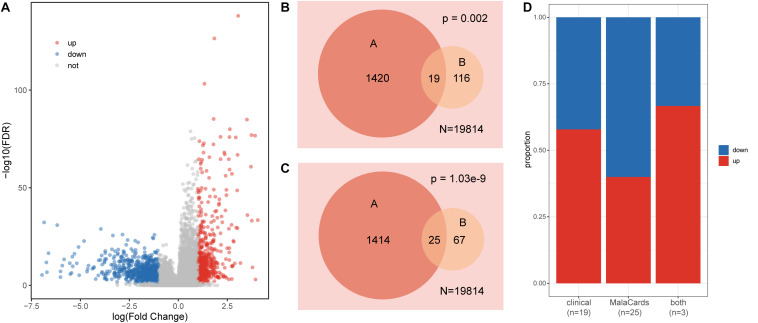
Characteristics of gene expression in colon cancer. (A) Volcano plot of dysregulated genes in colon cancer. (B) Venn diagram displaying the relationships between dysregulated genes (A set) and clinical action genes (B set); N is the total gene number. (C) Venn diagram displaying the relationships between dysregulated genes (A set) and colon cancer-related genes (B set); N is the total gene number. (D) The proportion of up- and downregulated genes in each set.